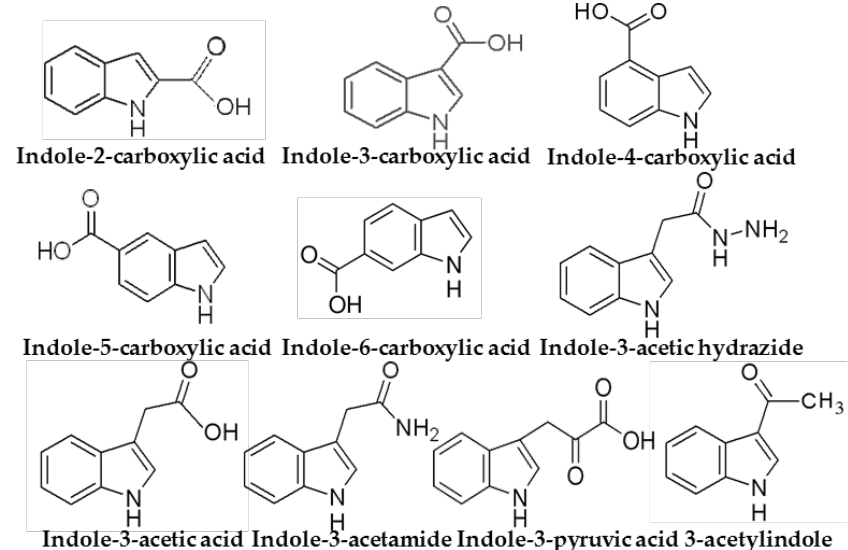
Figure 1. Chemical structures of the 10 indole compounds.